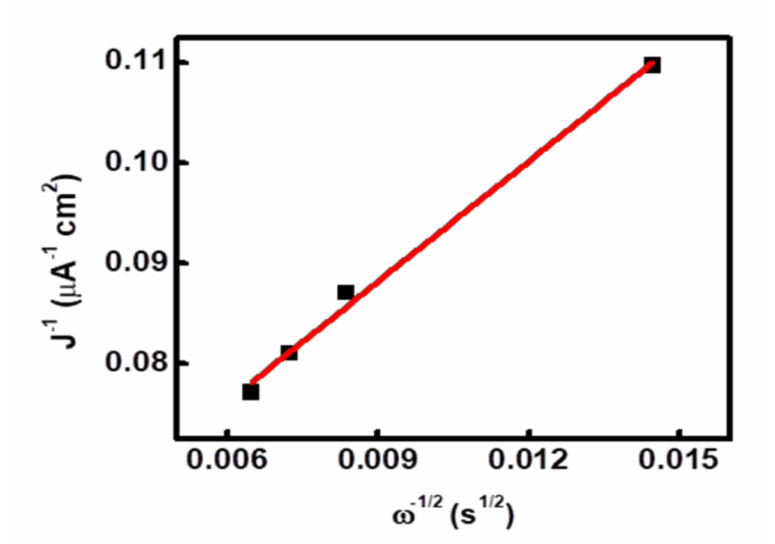
Figure 5. Koutecky–Levich plots of